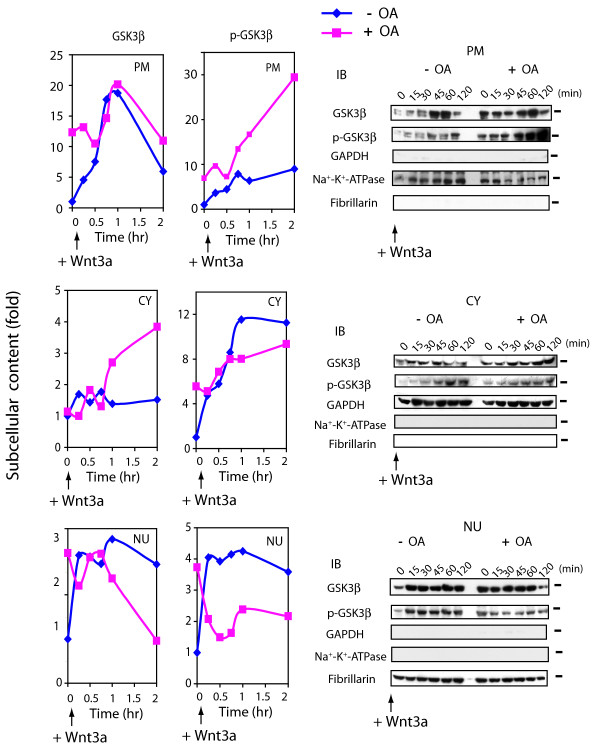
Suppression of PP2A provokes shuttling and phosphorylation of GSK3β. F9 cells expressed Rfz1 were treated without (-) or with (+) OA for 1 hr and then stimulated without (time + 0) or with Wnt3a for the indicated time periods. At indicated time points, cell cultures were harvested, disrupted, and subjected to subcellular fractionation to plasma membrane (PM), cytoplasm (CY) and nuclei (NU) fractions, as described in the Methods. Samples of each fraction were subjected to protein determination, SDS-PAGE, and the resolved proteins blotted and stained with antibodies specific for GSK3β and with antibodies specific for Ser9 phospho-GSK3β. Left-handed panel shows the quantitative analysis of the blots for Wnt3a alone (blue line) or Wnt3a in the presence of OA (pink line). The data are displayed as fold of control (time zero set to 1). Right-handed panel displays immunoblots stained with GSK3β and phospho-GSK3β (Ser 9) antibodies as well as antibodies specific for subcellular fractions, (i.e., marker proteins). The results shown are derived from a single experiment, representative of two additional experiments.